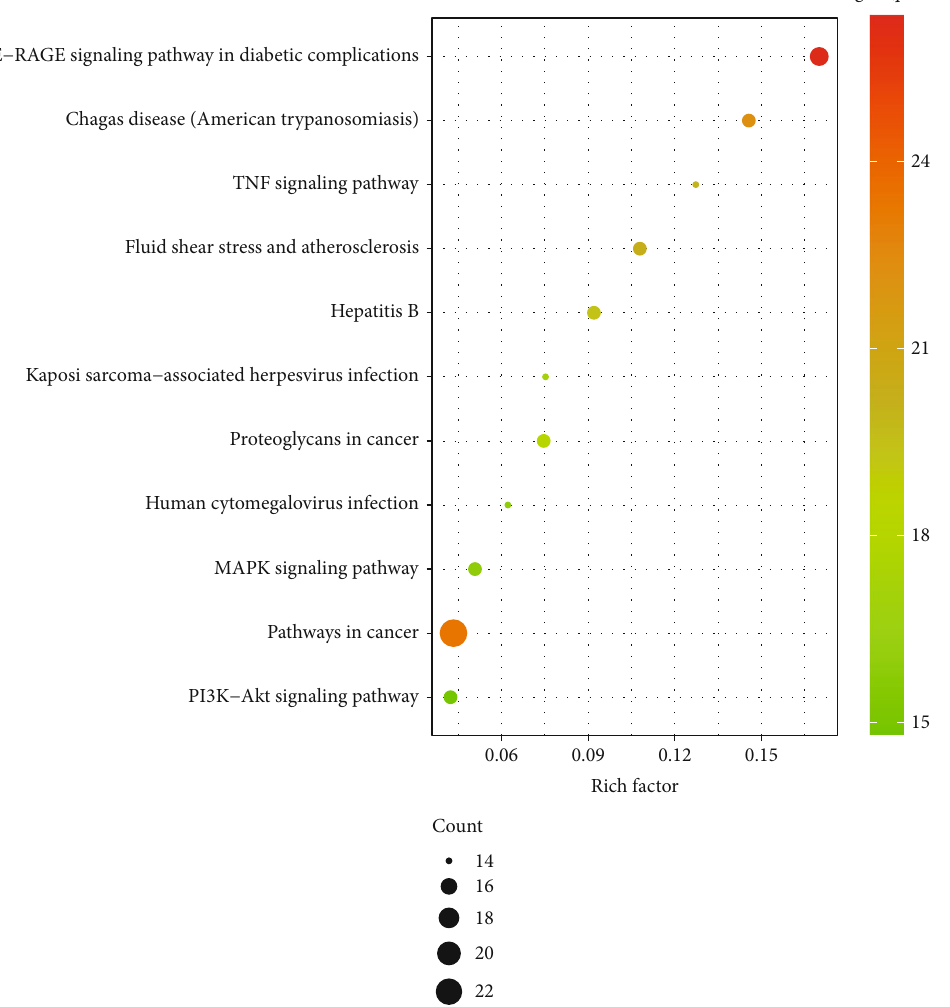
Figure 6: KEGG enrichment